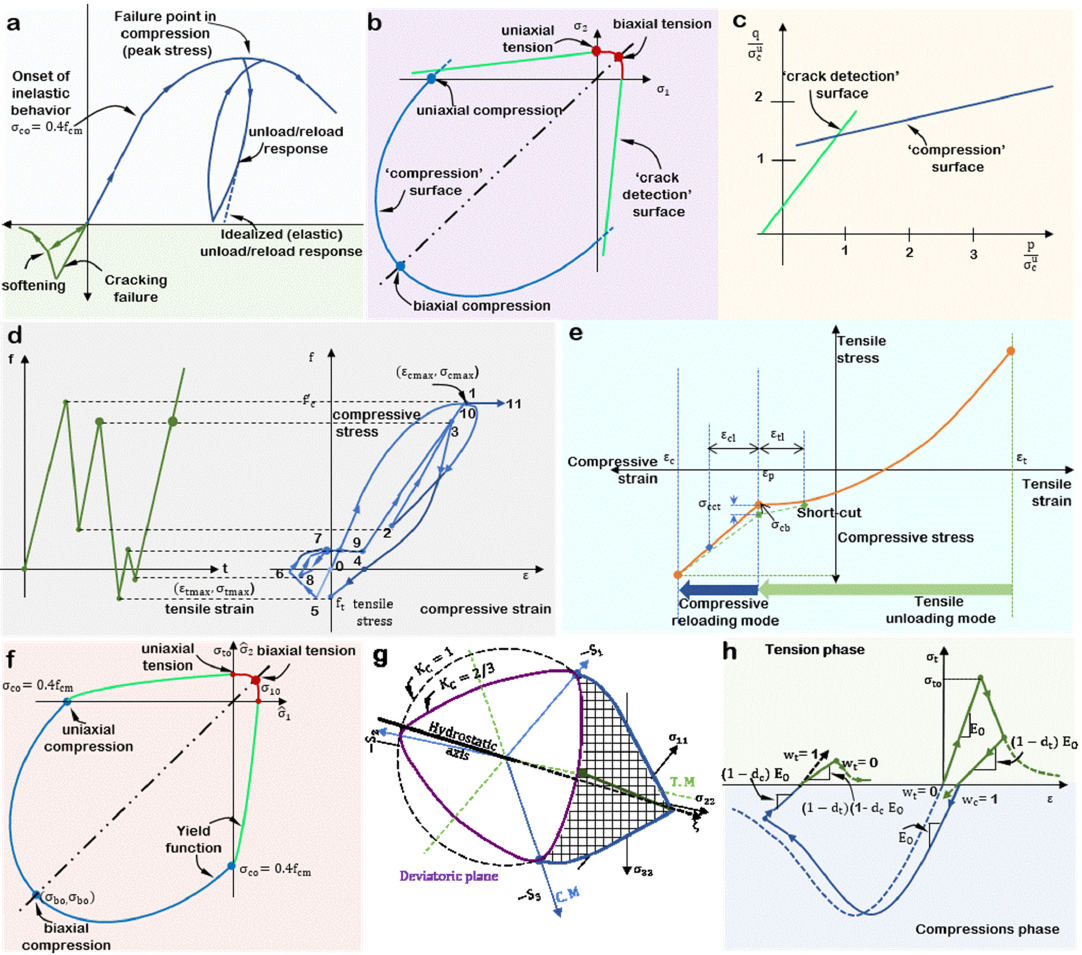
Figure 2. Some concrete models available in commercial FE numerical software. ( a ) Uniaxial behavior of plain concrete. ( b ) Yield and failure surface in plane stress for CSC model in Abaqus. ( c ) Yield and failure surface in the (p–q) plane for CSC model in Abaqus. ( d ) Hysteresis for Maekawa model from Diana FEA. ( e ) Crack-reclosing behavior for Maekawa model from Diana FEA. ( f ) Yield surface in plane stress for CDP model in Abaqus. ( g ) Yield surfaces in the deviatoric plane for the CDP model in Abaqus. ( h ) Uniaxial load cycle for CDP model in Abaqus.